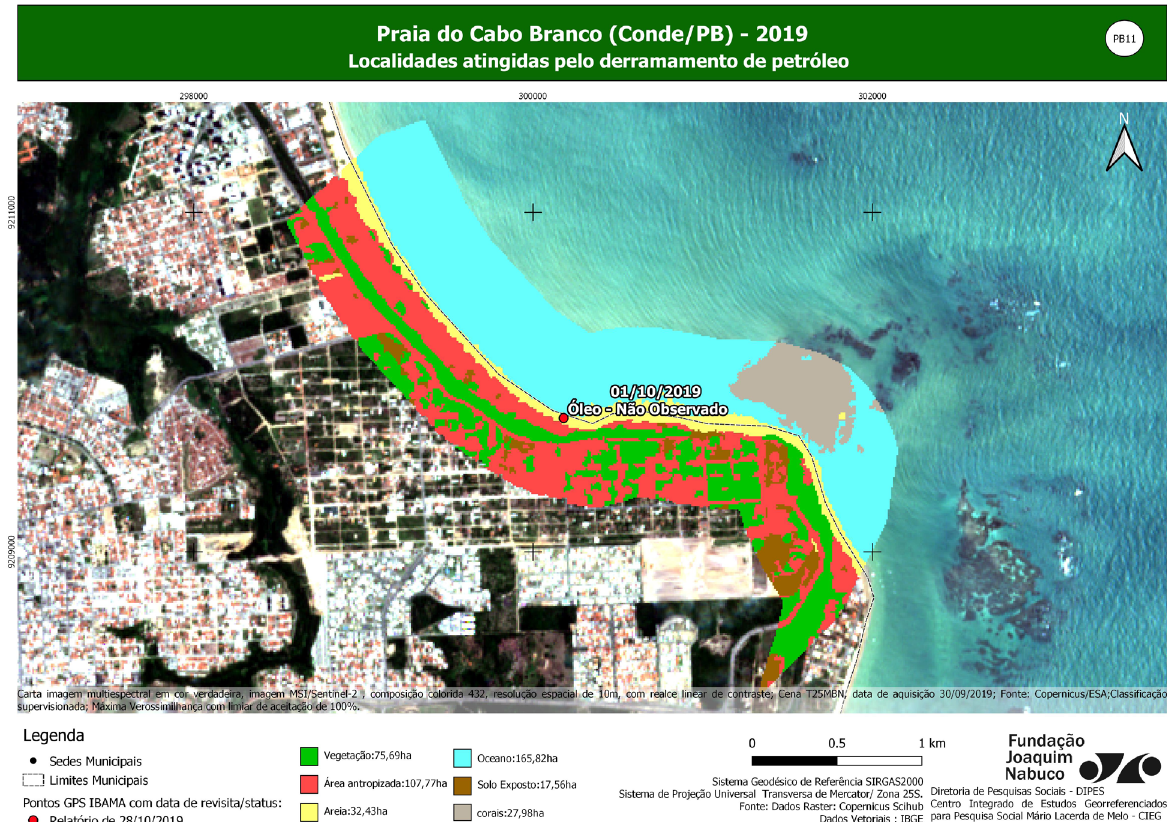
Figure 8. Thematic map obtained from the Supervisioned Classification in multispectral image of the MSI / Sentinel-2 satellite. Source: Authors’ elaboration based on Sentinel-2